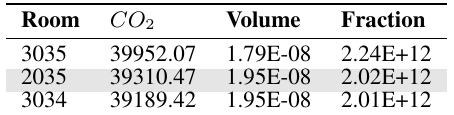
Table 3. Top-3 teaching room in “Red Center” building Room